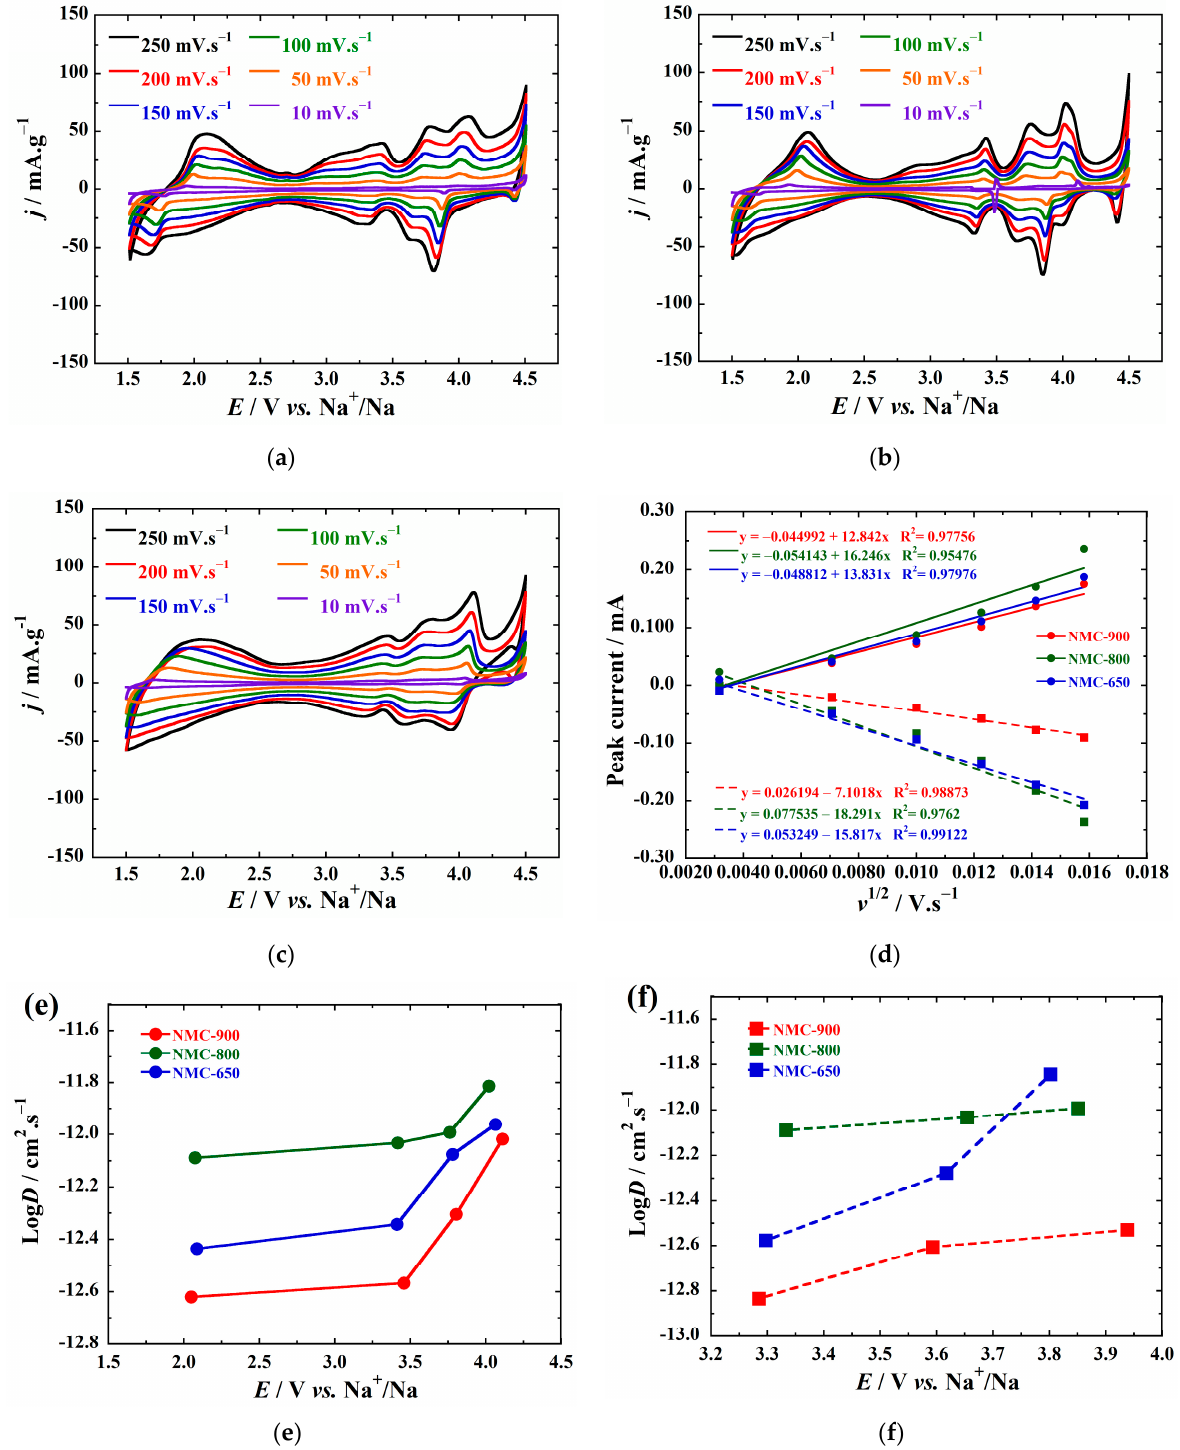
Figure 7. Cyclic voltammogram scanned at various scan rates of ( a ) NMC-900, ( b ) NMC-800 and ( c ) NMC-650. ( d ) The plot of current intensity at a pair of oxidation/reduction peaks is located at about 4 V versus the square root of the scan rate of the samples; The plot of di ff usion coe ffi cients calculated at ( e ) oxidation and ( f ) reduction peaks.